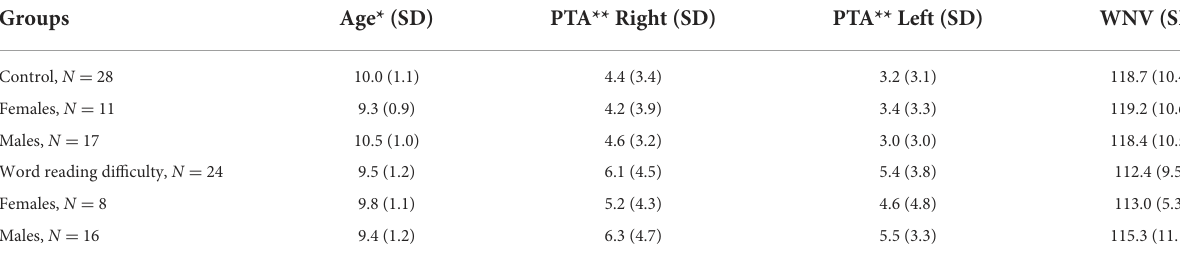
TABLE 1 Means (and SDs in parentheses) for age, PTA (0.5–4kHz), and WNV scores for children in the two groups.